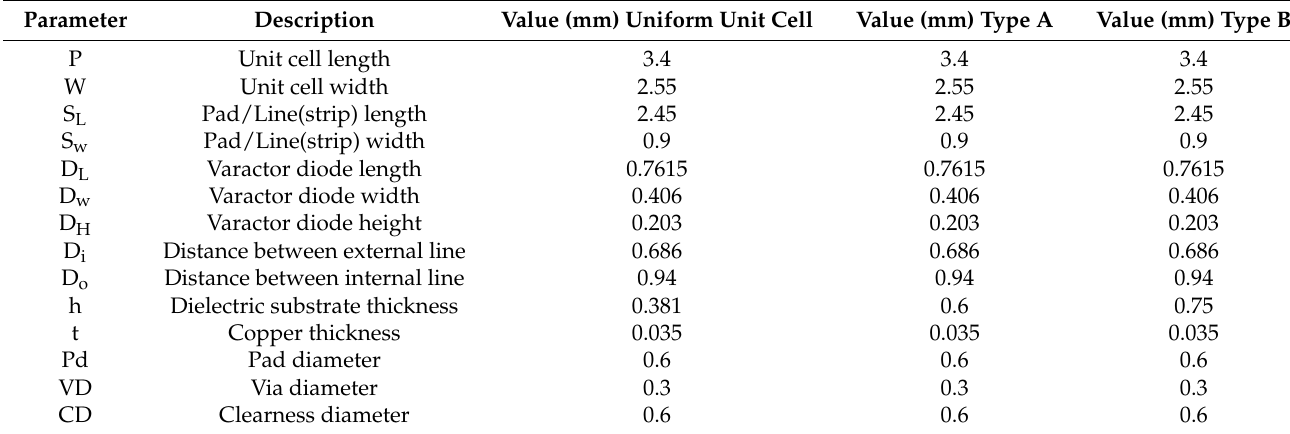
Table 1. Geometric unit cell parameters.